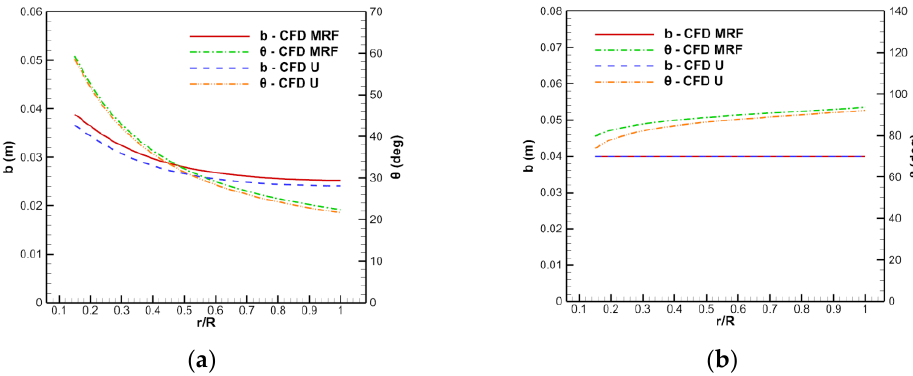
Figure 20. Comparison of the chord length and torsion angle of the blade of the 400 ducted fan: ( a )